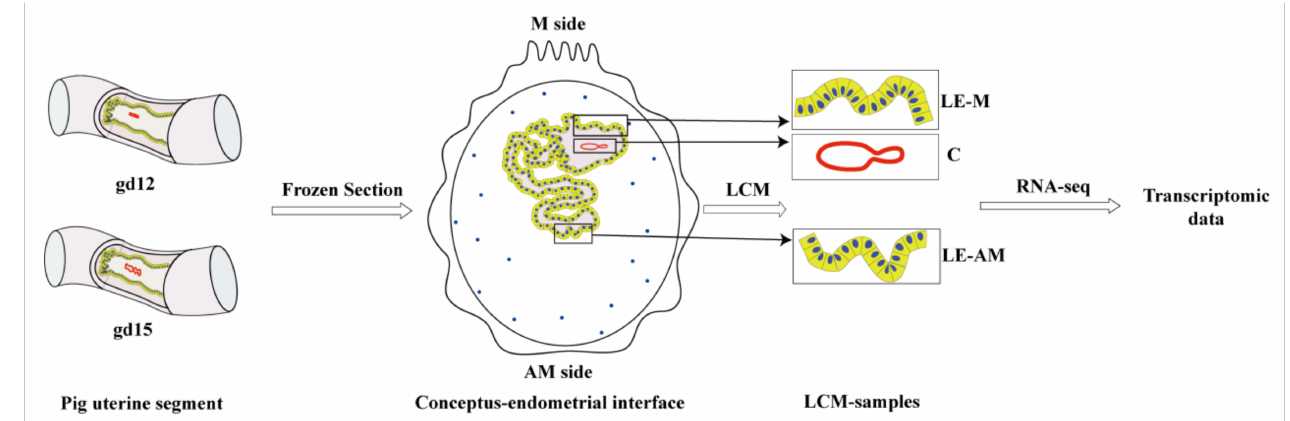
Figure 1. Schematic of the experimental workflow. Pig uterine segments in which conceptuses were not flushed out were collected from gestational days 12 (gd12, pre-attachment stage) and 15 (gd15, attachment stage) respectively, and were cross-sectioned by using a cryostat. Three spatially distinct compartments of the conceptus–endometrial interface from each stage were laser capture micro-dissected (LCM) and analyzed by RNA-seq to generate the spatial-temporal transcriptomic data. LE-M: endometrial luminal epithelium at the mesometrial side; LE-AM: endometrial luminal epithelium at the anti-mesometrial side; C: